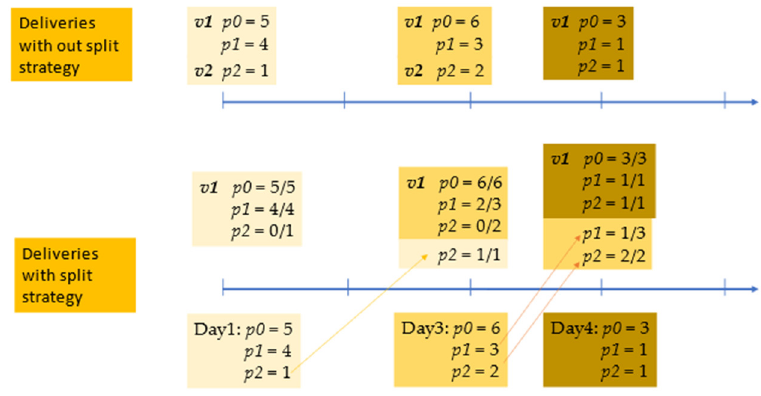
Figure 1. Example of deliveries without and with the postponing strategy.